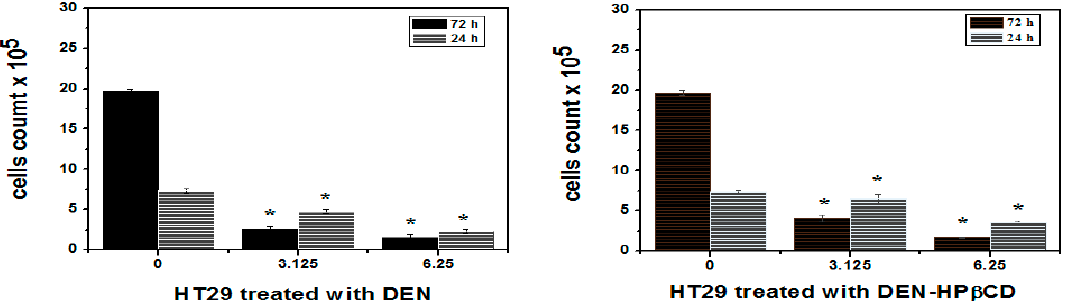
Figure 4. Trypan blue exclusion assay for cell viability of HT29 treated cells after 24 and 72 h of treatment with DEN and /or DEN-HP β CD complex. Mean ± standard deviation (SD). ( n = 3 well/treatment). * p < 0.05 compared with untreated cells.